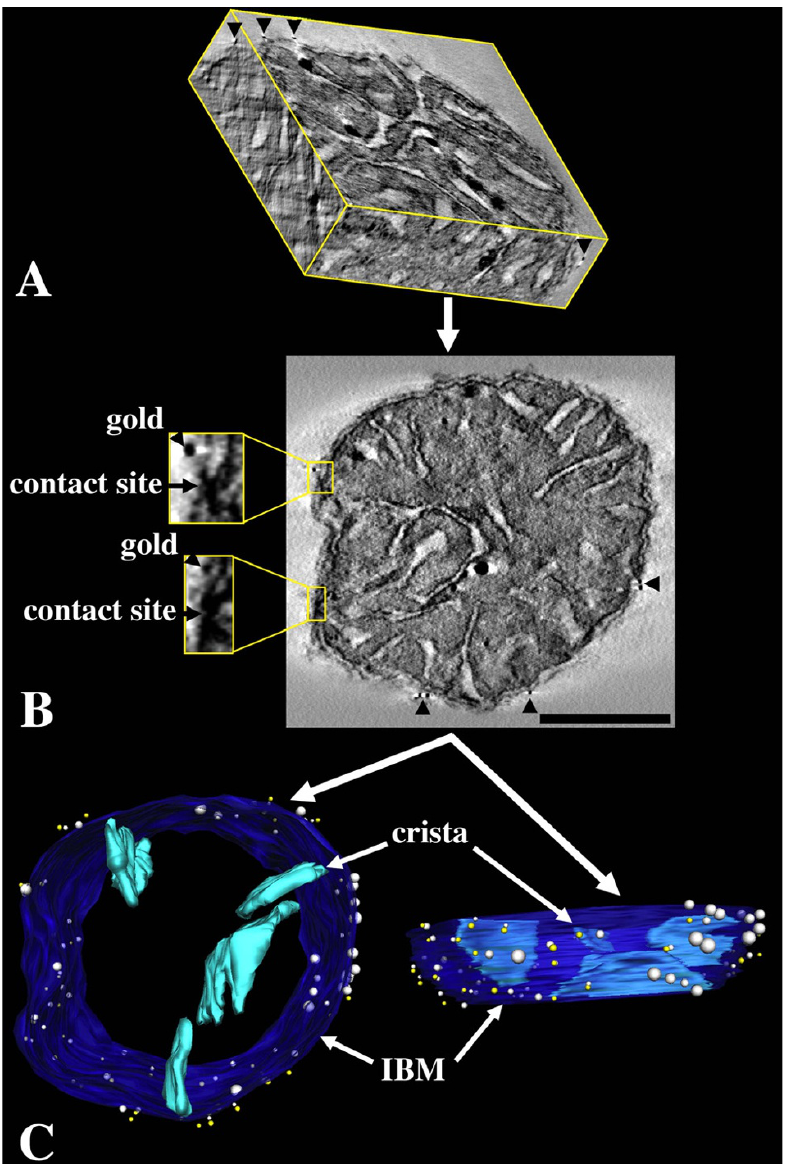
Figure 3 Elements of a tomographic reconstruction of a tBid G94E -labeled mitochondrion highlight the association of tBid with contact sites. a) Portion of the tomographic volume sliced in three perpendicular planes. Thick sections were examined by intermedi- ate voltage electron microscopy and were used to generate reconstructions of the immunogold-labeled outer membrane. The visualization tool ANALYZE allows the tomographic volume to be rotated and resectioned along any axis, thereby revealing both internal and surface structures along with the gold labels; it also provides the ability to correlate 2-D and 3-D views of the same region or substructure. Three-dimensional perspectives allowed us to track features, such as gold particles (arrowheads), along perpendicular faces. b) Slice through the volume. Several gold particles are visible (arrowheads) in this 2 nm slice, includ- ing two closely associated with contact sites (insets; 3x magnification) The scale bar = 500 nm and applies to all panels. c) Per- pendicular views of the surface-rendered volume with selected components segmented. The visualization tool SYNU allows the surface-rendered volume to be viewed in any orientation. For clarity in visualizing the contact sites (white spheres) and gold particles (yellow spheres), the outer membrane is not shown. The inner boundary membrane (IBM) is shown in dark blue and was segmented separately from individual cristae (light blue). Only four cristae are shown to demonstrate the lamellar architecture common in liver mitochondria. Where gold particles were aggregated, only one particle is shown. The IBM was made translucent in order to visualize the